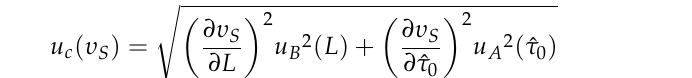
Table 1. Summary of the test results.